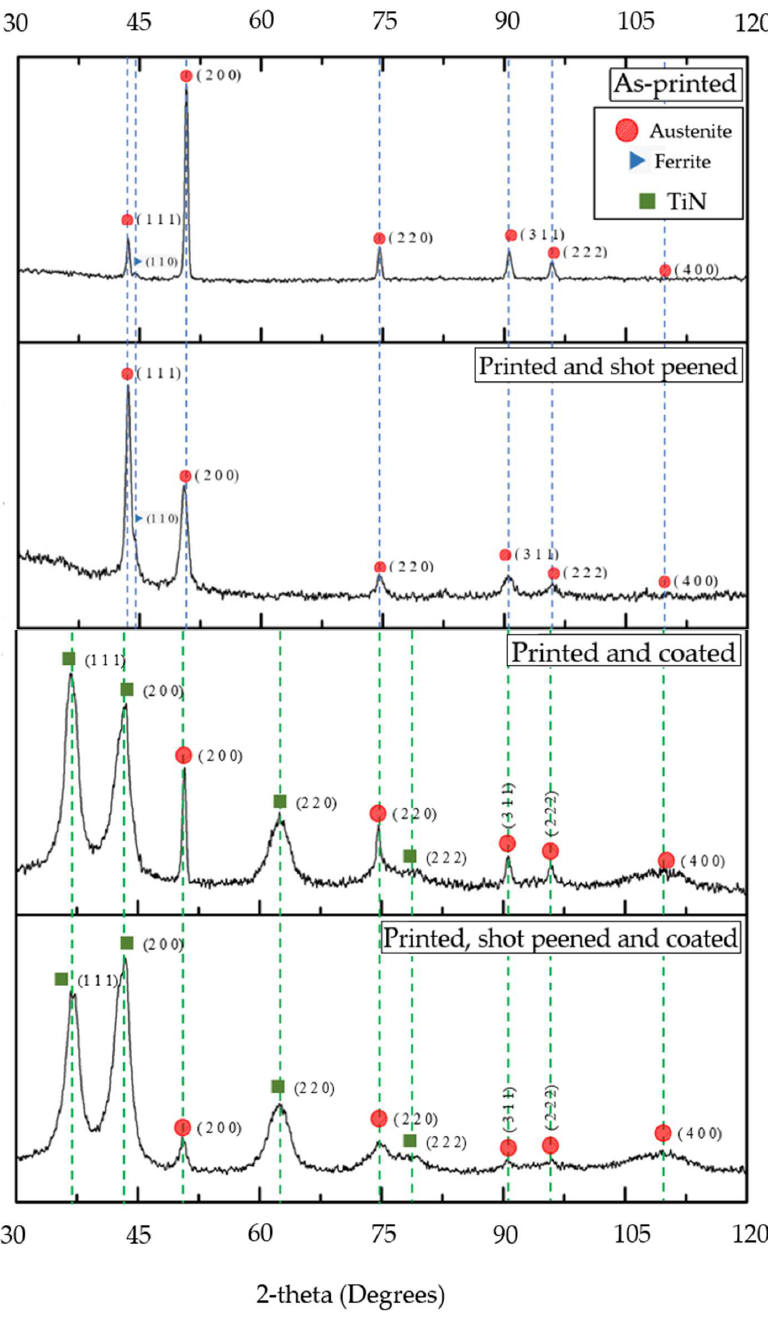
Figure 8. XRD for the as-printed (AP), printed and shot peened (PSP), printed and coated (PC) and printed, shot peened and coated (PSPC).